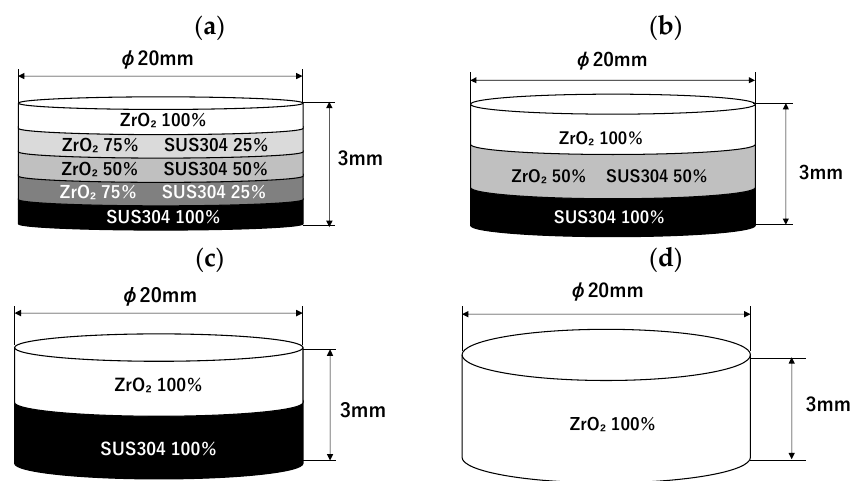
Figure 3. Schematic illustrations of multi- and single-layered materials. ( a ) 5-layered materials, ( b ) 3-layered materials, ( c ) 2-layered (cladding) materials and ( d ) ZrO 2 single-layer materials.